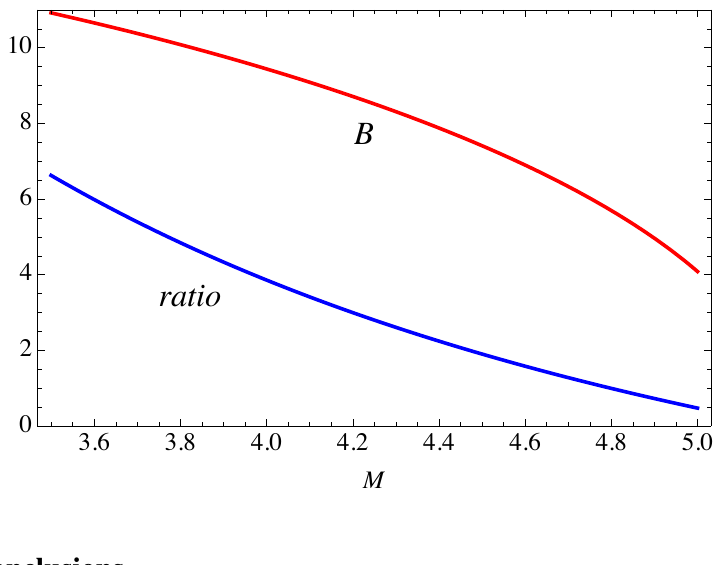
Figure 9. The ratio of magnetic field energy to plasma energy and the magnetic field strength B (Gauss) in the corona as a function of the Mach number. See the text and Figure 8 for data.